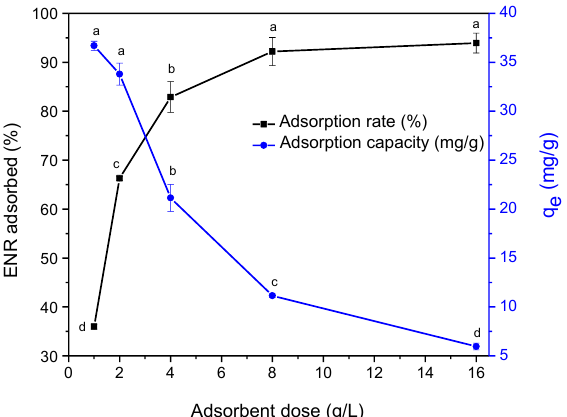
Figure 4. The effect of adsorbent dosage on the removal of enrofloxacin (contact time 1440 min; 100 mg ENR/L; pH 7; and temperature 298 K). For each parameter, those means that do not share a common superscript differ significantly (Tukey p < 0.05).